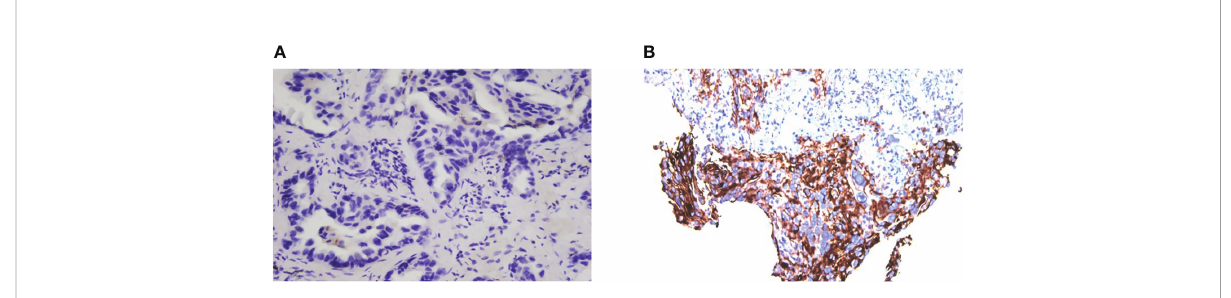
FIGURE 3 Evaluation of PD-L1 expression of tumor cells. PD-L1 expression of Case 1 in November 2018 (A) , TPS = 0 and July 2020 (B) , TPS = 60% (Dako